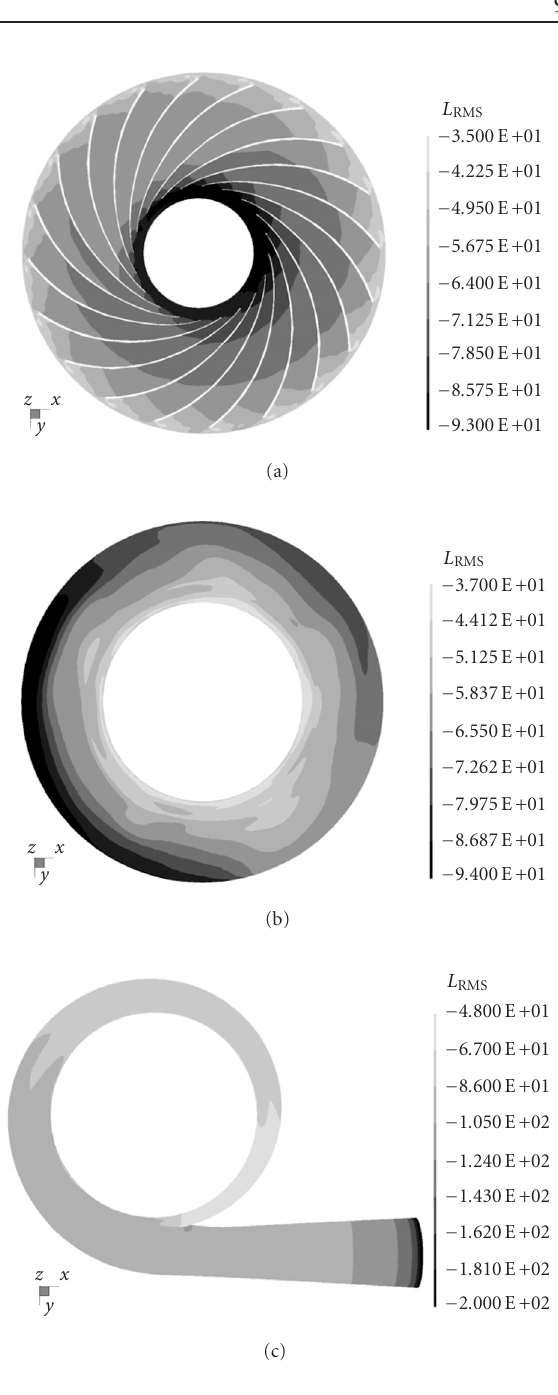
Figure 9: Variance of pressure level in the vaneless case at design conditions: (a) impeller center plane, (b) di ff user center plane, and (c) volute